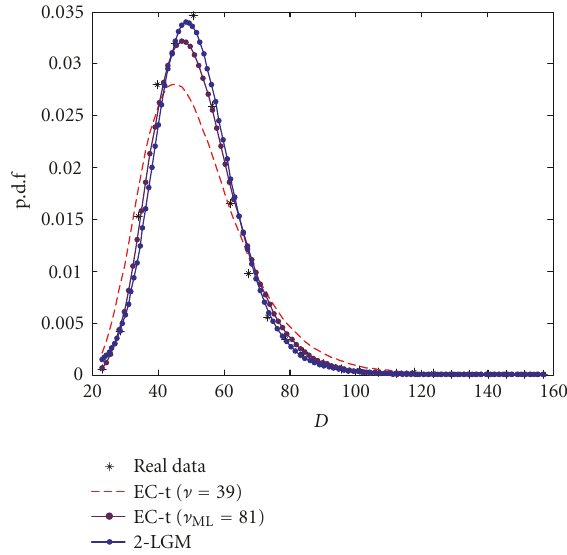
Figure 5: Class no.2 (bare soil) : p.d.f.’s of D for the real data and for three theoretical